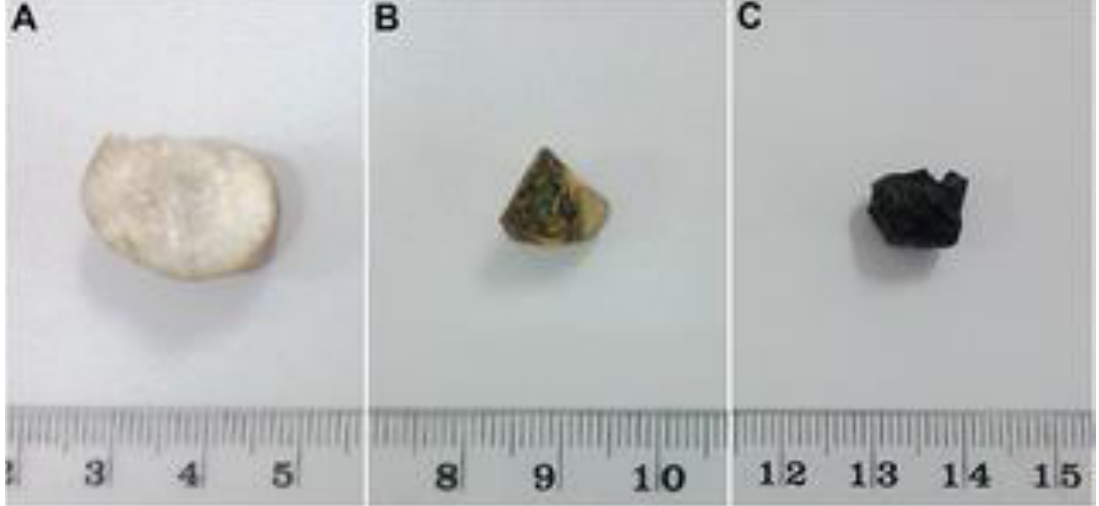
Figure 2: Cross sectional appearance of each type of gallstone. A—Pure cholesterol B—Mixed. C—Pigment